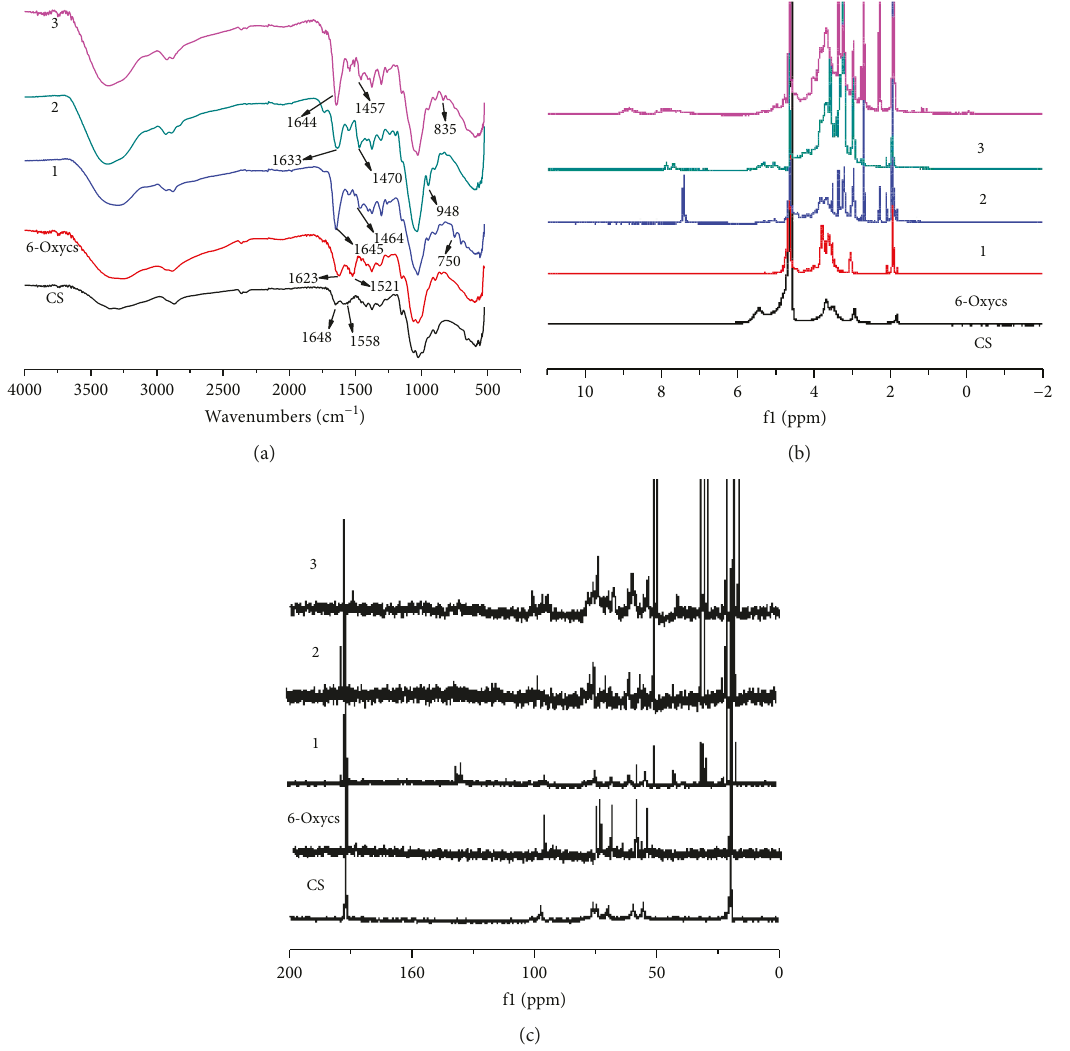
Figure 1: The chemical structure of chitosan and chitosan derivatives. (a) FT-IR spectra, (b) 1 H NMR, and (c) 13 C NMR of chitosan, 6-oxychitosan, 1, 2, and 3. Table 1: The elemental analysis results, yield, and DS of the quaternized 6-oxychitosan derivatives.